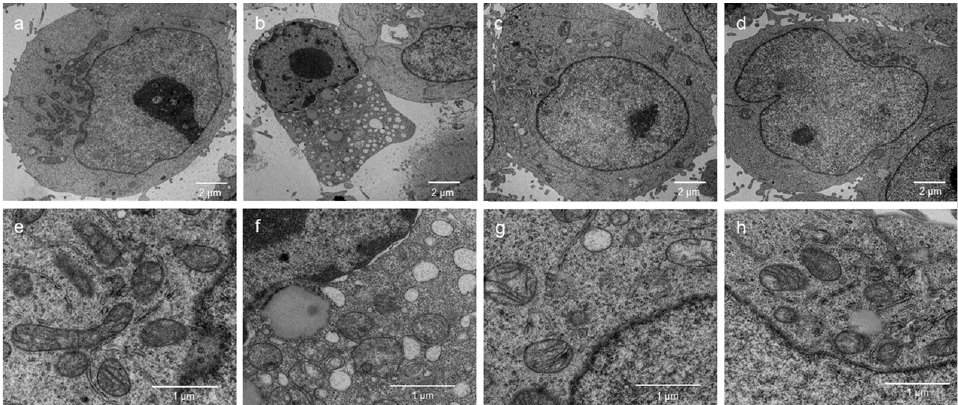
Figure 9. The effect of NMCP-2 on the ultrastructural changes of HEK 293T cells exposed to H 2 O 2 . Transmission electron micrograms show the ultrastructure of HEK 293T cells before ( a , e ) and after ( b , f ) H 2 O 2 injury or treatment with 5 µg/mL NMCP-2 ( c , g ) or 25 µg/mL NMCP-2 ( d , h ) after the injury. 2.7. mRNA Expression of Apoptosis Related Genes after NMCP-2 Exposure Impaired redox status leads to accumulation of ROS, which activates mitochondrial stress.